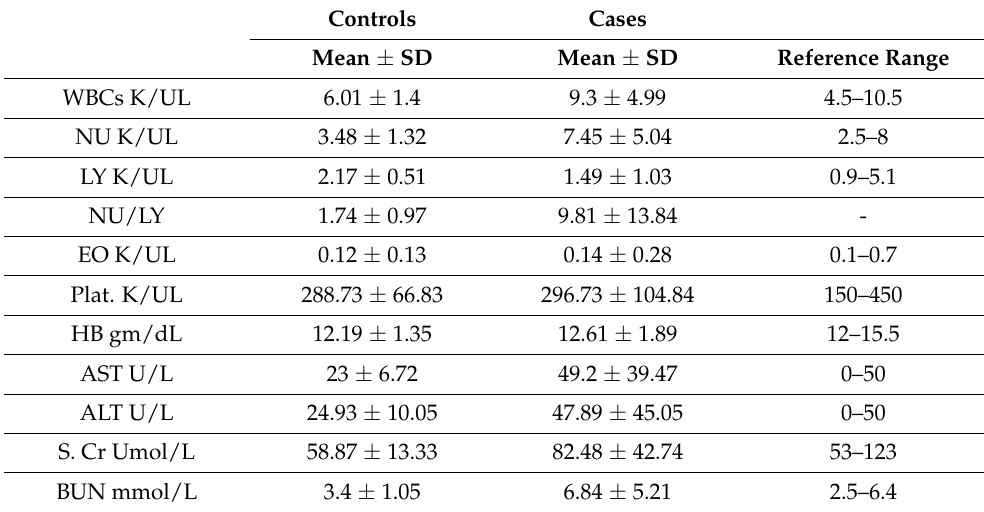
Table 2. Comparison of the laboratory data measured between cases and